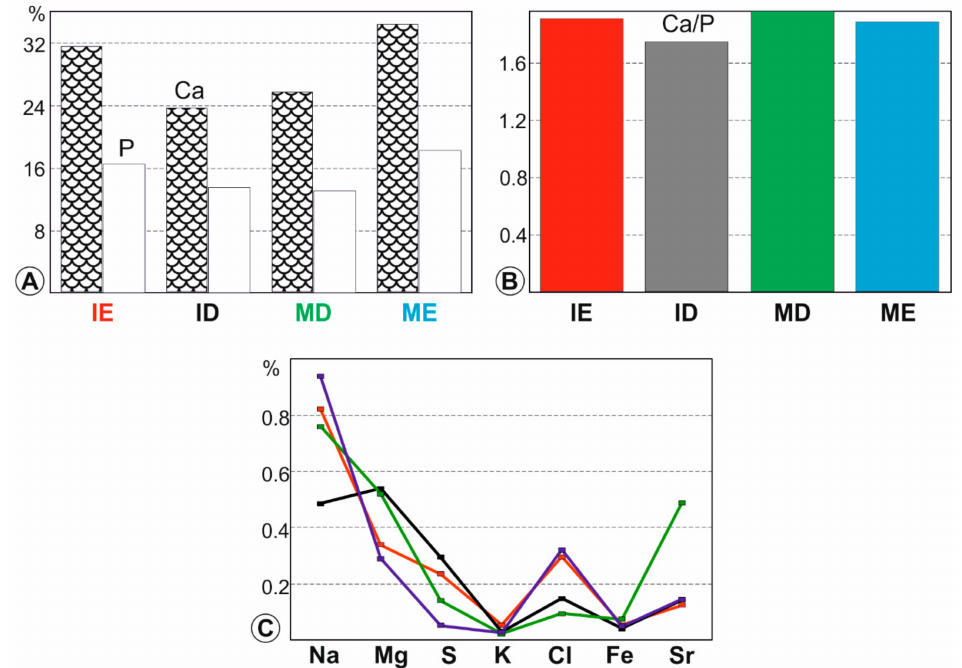
Figure 9. Chemical composition of digested teeth. ( A )—Average major elements (P and Ca) contents; ( B )—Average Ca / P ratios; ( C )—Average minor element contents. ME: molar enamel, IE: incisor enamel, MD: molar dentine, ID: incisor dentine.